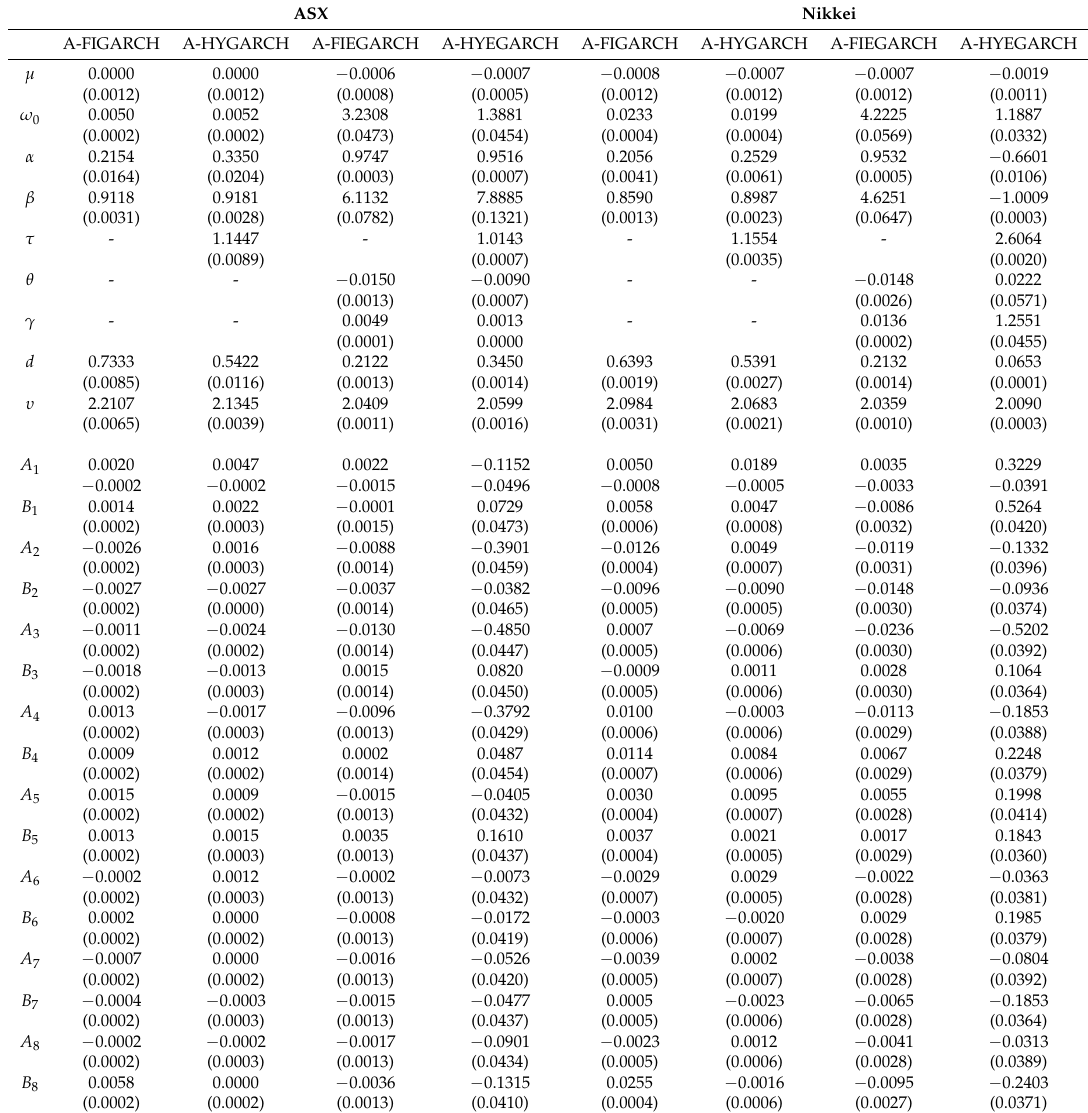
Table 9. Estimation of A-FIGARCH, A-HYGARCH, A-FIEGARCH and A-HYEGARCH models for ASX and